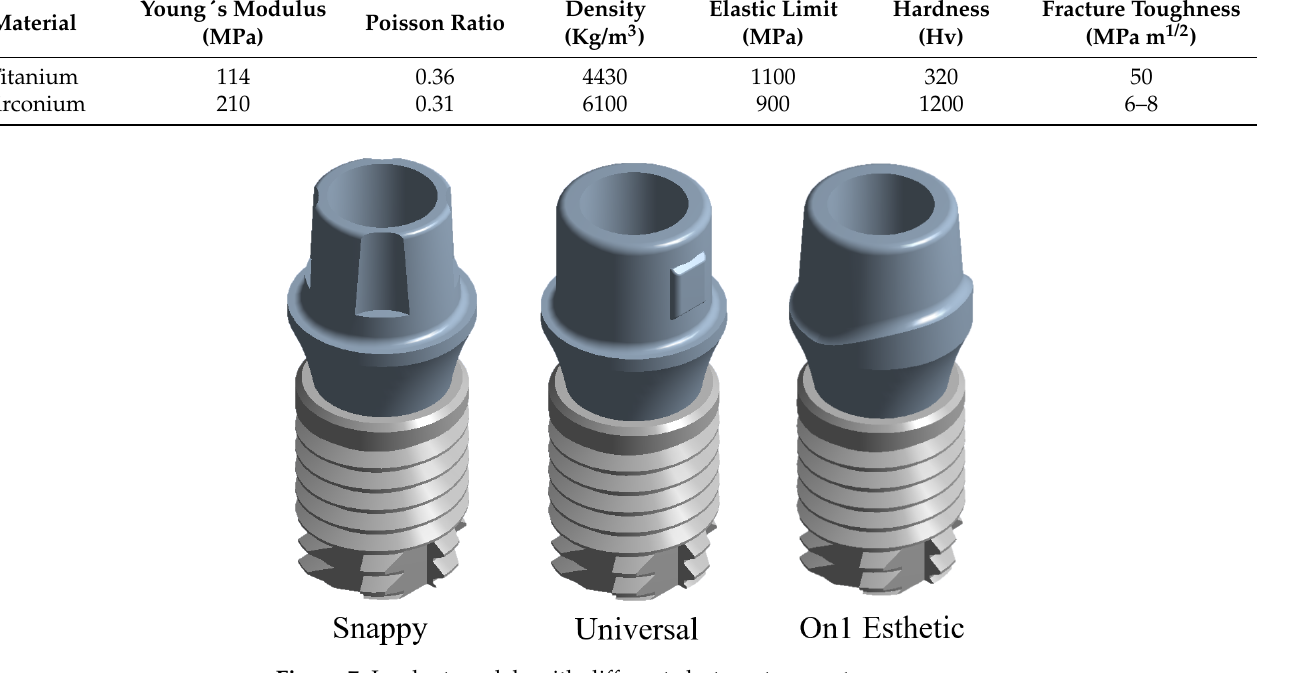
Figure 7. Implant models with different abutment geometry.